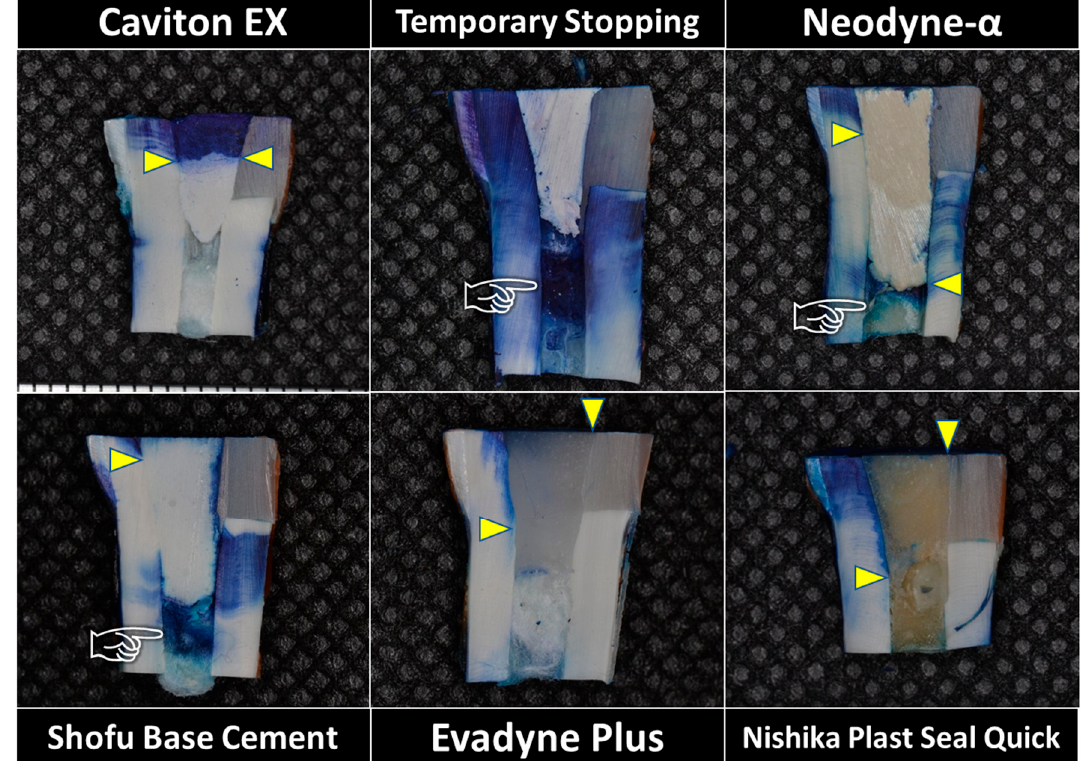
Figure 3. Representative photographs in each group after measurement of the penetration depth (yellow arrowhead). Note that the infiltration of dye on the cavity wall that was built up by resin composite could not be detected when a resin-based temporary sealing material was used, although deeper infiltration of the dye was observed on the cavity wall of the dentin side. It can be detected that a cotton ball placed directly below the temporary restoration was also stained by methylene blue in Temporary Stopping, Neodyne- α and Shofu Base Cement (pointer).